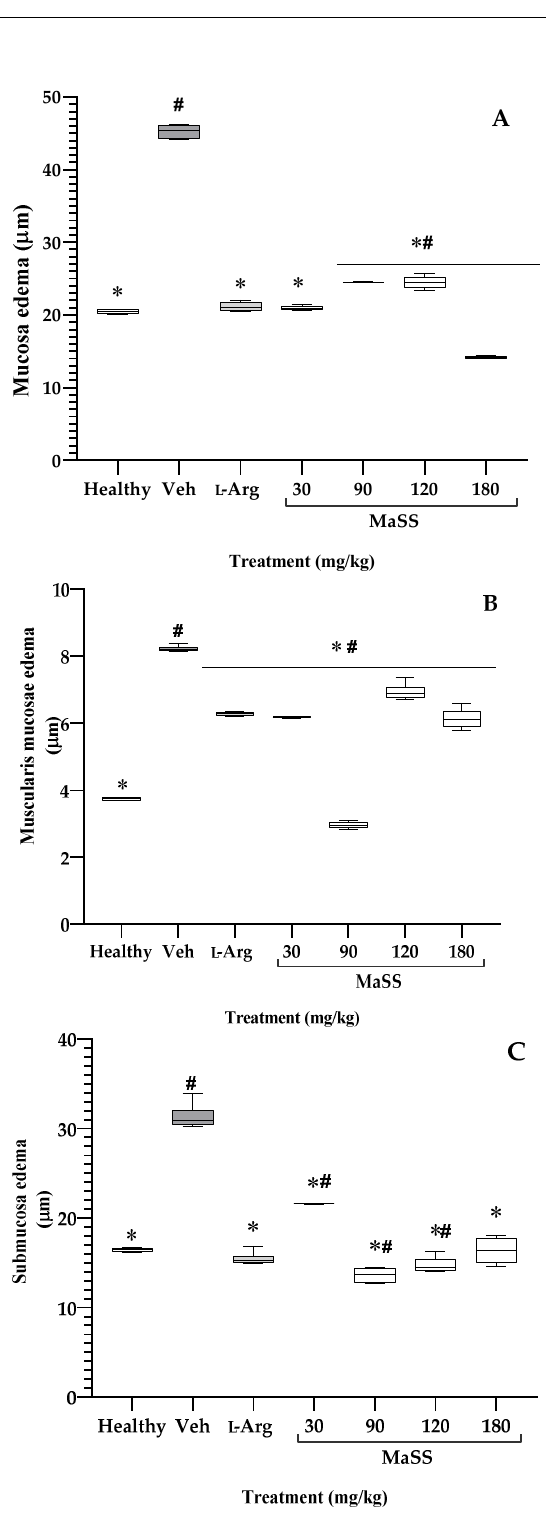
Figure 6. Effect of different doses of MaS, the mixture of kaempferol 3- O -sophoroside and kaempferol 3- O -sambubioside, obtained from M. arboreus , on microscopic edema of mucosa ( A ), muscularis mucosa ( B ), and submucosa ( C ) from the stomach of rats with gastric lesions-induced with ethanol. Healthy = rats without lesions; Veh = rats with gastric lesions. L-Arg = amino acid L-arginine. ANOVA post-Tukey’s test (n = 5, ± ED, # p < 0.05 when groups are compared with the healthy group; * p < 0.05 compared with Veh